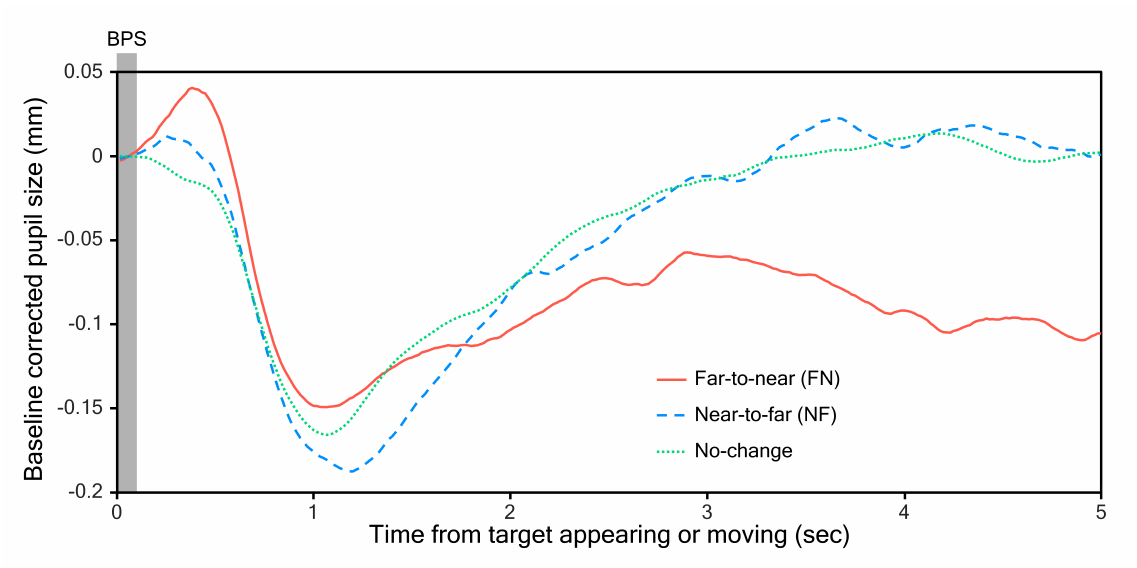
Figure 7. Grand mean pupil traces of 5 second target presentations in experiment 2. At 0 s targets either appeared (after a dis- tance switch) or jumped to a different location at the same distance. The period from 0 to 0.1 s, marked by the grey box, indi- cates the time period over which baseline pupil size (BPS) was